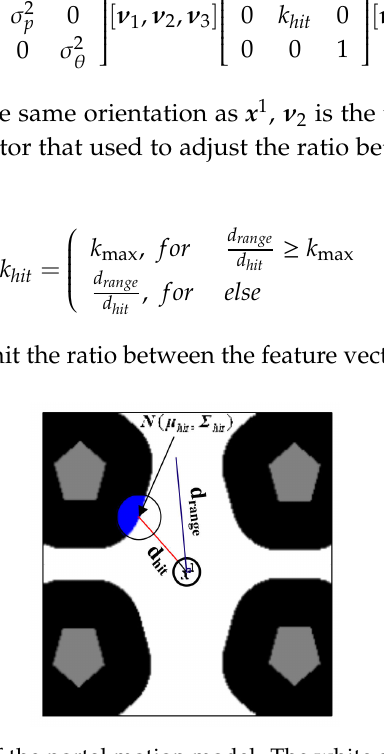
Figure 6. Schematic diagram of the portal motion model. The white area, black area, and gray area represent an ambiguous area, an unambiguous area, and area occupied by obstacles, respectively. x 1 is a pose sample. The blue transparent circle is the Gaussian distribution N ( µ hit , Σ hit ) , and the blue opaque portion expresses the truncated Gaussian distribution of Equation